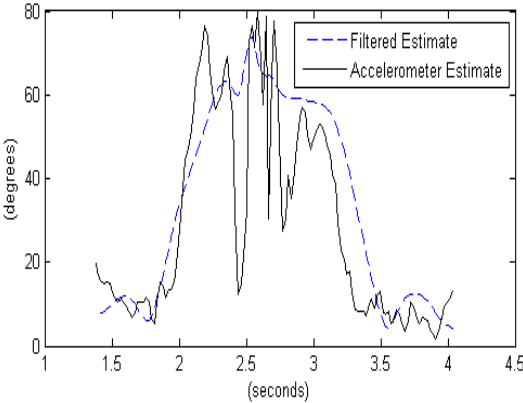
Figure 3. Accelerometer-only orientation estimates compared to AHRS algorithm used for a throwing motion.